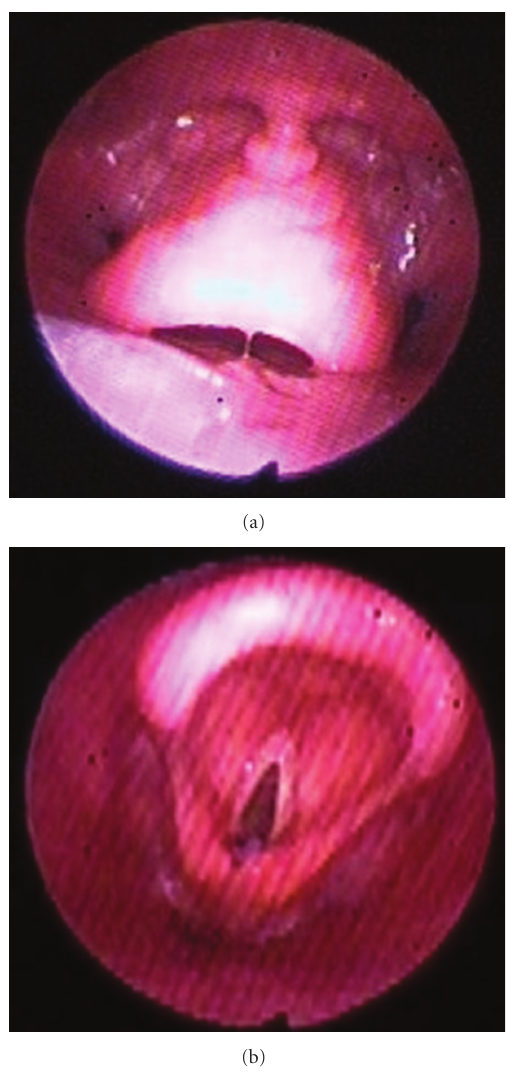
Figure 1: (a) Posteriorly displaced epiglottis secondary to tongue base collapse. (b) Dramatic improvement of the airway upon lifting the tongue base anteriorly using jaw